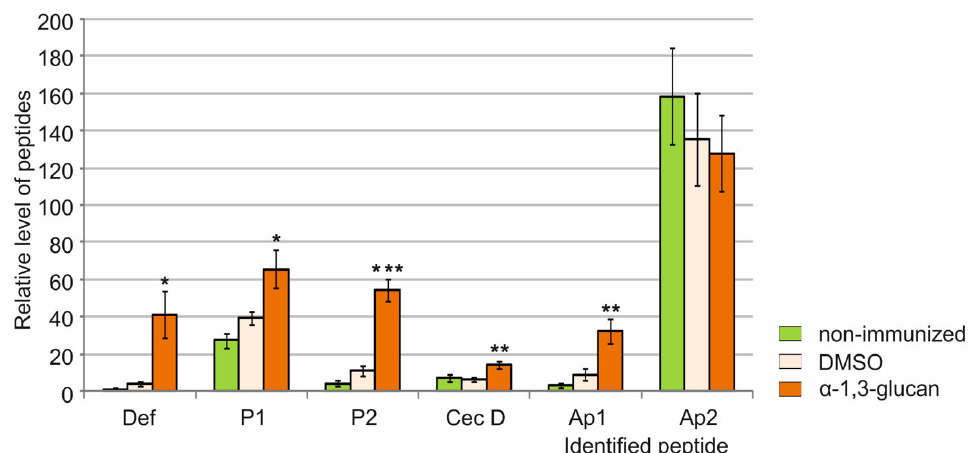
Figure 5. Relative level of defense peptides identified in the hemolymph of G. mellonella larvae treated with A. niger α -1,3-glucan. The larvae were injected with DMSO (control) or α -1,3-glucan (5 µ g) and hemolymph was collected 24 h post-treatment. The peptide levels were determined after separation by HPLC and identified via sequencing by Edman degradation as described in the Materials and Methods. Statistical significance was determined for the differences between the mean values (from three independent experiments) for α -1,3-glucan and DMSO and marked with asterisks: * p < 0.05, ** p ≤ 0.01, *** p ≤ 0.001. Def— Galleria defensin (galiomicin), P1—Proline-rich peptide